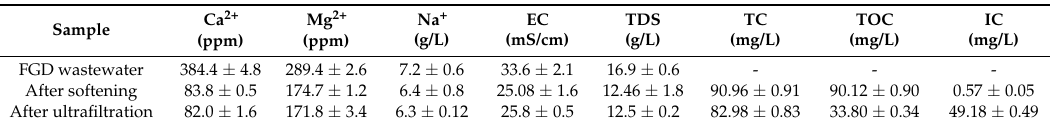
Table 2. Composition of flue gas desulfurization (FGD) wastewaters before and after pre-treatment processes (EC, electrical conductivity; TDS, total dissolved solids; TC, total carbon; TOC, total organic carbon; IC, inorganic